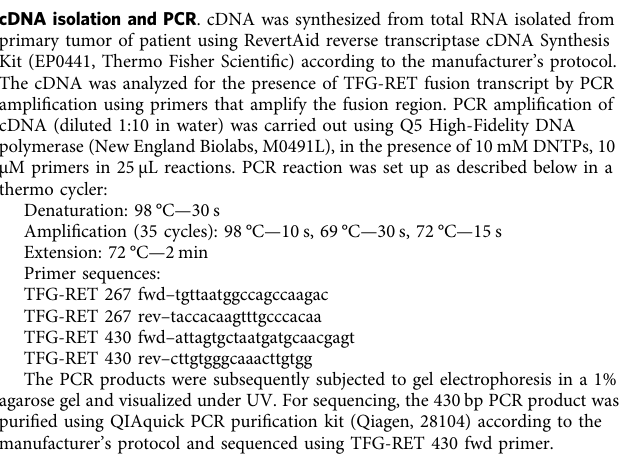
Fig. 4 TFG domains have a role in the TFG-RET heteromerization and oncogenicity. a Structural comparison of TFG-PB1 vs Dvl2 DIX or p62 PB1 and the TFG-PB1 model showing the head region (deep blue) and tail region (teal) based on the DIX polymer of hDvl24WIP (head (slate), tail (aquamarine)). b Mutations in PB1 domain (top panel) — Comparison of PB1 sequences (not entire) of p62 and TFG-RET. Conserved residues Lys14, Arg22 and Arg23 were substituted with oppositely charged Glu to create PB1 domain mutant TFG-RET (TFG-RETK14ER22ER23E). CC domain (bottom panel) — Leu97 to Glu124 comprise the CC domain of TFG-RET. This domain was deleted to obtain the CC deletion mutant of TFG-RET (TFG-RET Δ 97-124). c , d Lysates collected from HeLa cells transiently expressing indicated constructs were loaded on Superose-6 gel fi ltration column. Collected fractions (every second fraction) were subjected to western blotting. TFG-RET, TFG-RETK14ER22ER23E as well as TFG-RET Δ 97-124 were detected using V5 tag. Most of TFG-RET was detected in high molecular weight fractions, while TFG-RETK14ER22ER23E shifted toward the lower molecular weight fractions. (Molecular weight corresponding to the elution volume are indicated by the arrows above). Shown are representative data from at least two independent experiments. e Protein expression of TFG-RET, TFG-RETK14ER22ER23E and TFG-RET Δ 97-124 (pcDNA DEST V5.His vector) following transient transfection in HeLa cells was veri fi ed by Western blot analysis of the cell lysates (cytosolic fraction obtained after ultracentrifugation). Shown are representative data from at least two independent experiments. f Soft agar colony formation assay. Nthy-ori 3-1 cells stably expressing indicated constructs were cultured in soft agar for 2 weeks followed by staining with crystal violet. Error bars represent ± SEM ( n = 3). Paired t -test, two-tailed. Three independent experiments were performed: one experiment with technical triplicates, and two experiments with technical duplicates. *** p -value < 0.0001, ** p -value < 0.05. Shown are the fold changes in the number of colonies between the analyzed samples. g Immunoblot analysis of expression of TFG-RET, TFG-RET Δ 97-124 and TFG- RETK14ER22ER23E in Nthy-ori 3-1 cells. Shown are representative western blots from the experiments presented in